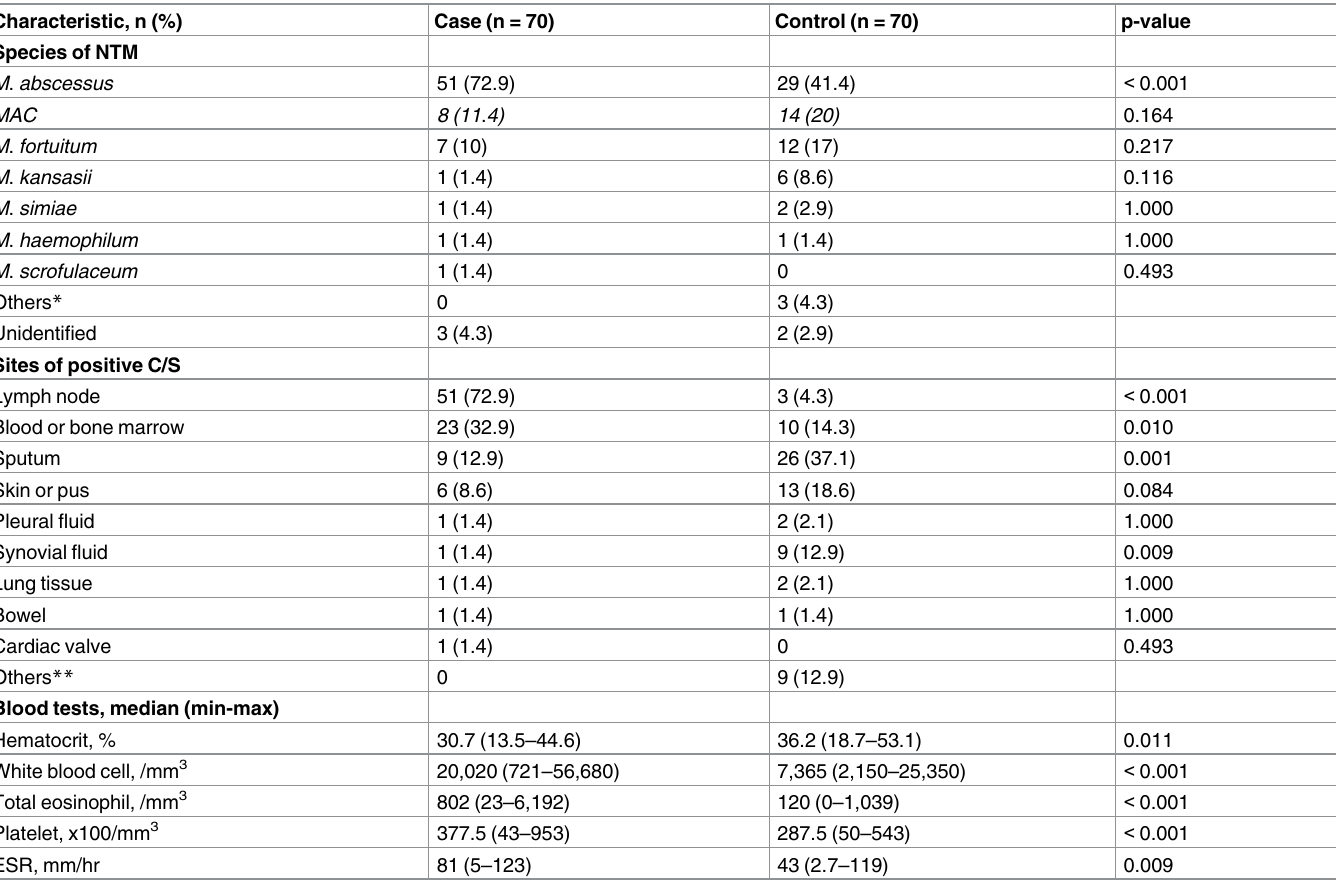
Table 2. Laboratory